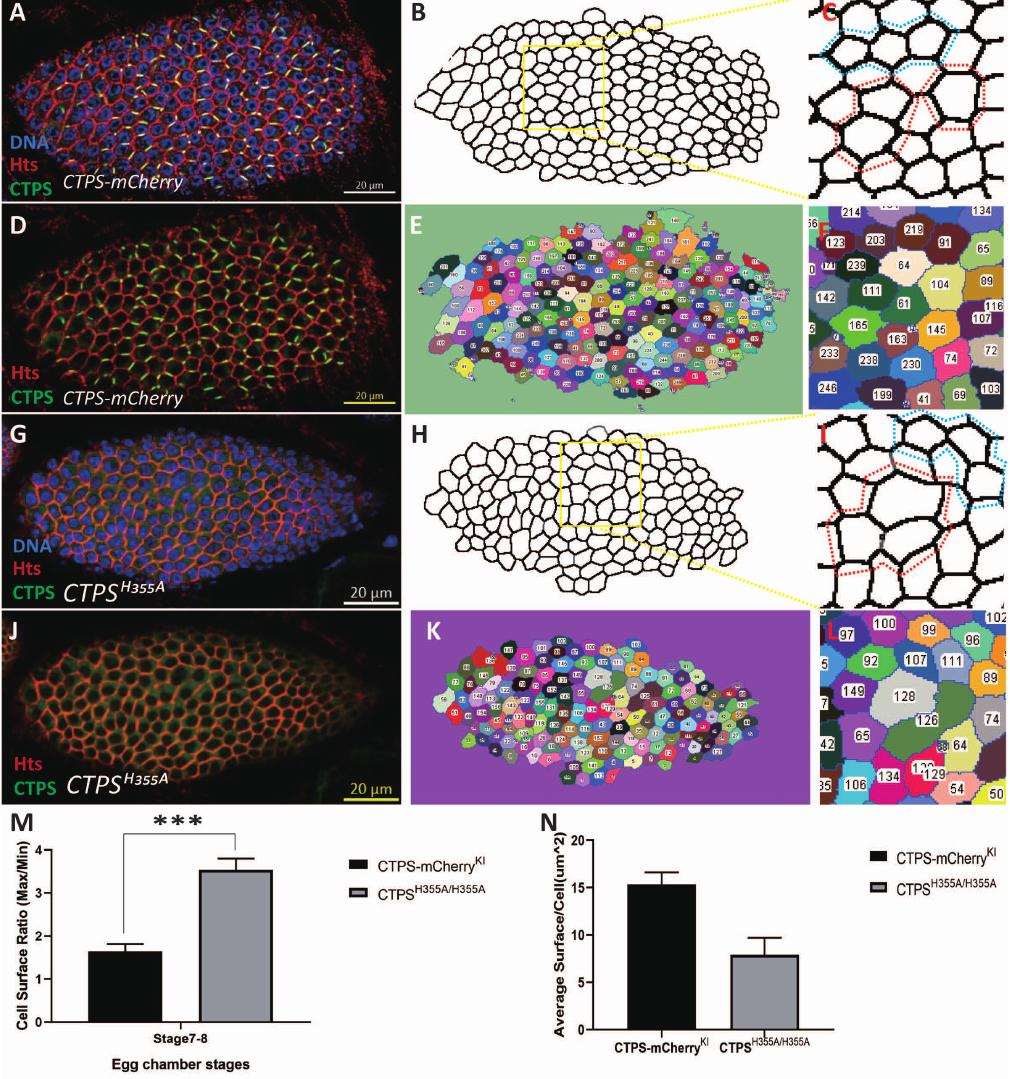
Figure 8. Quantitative morphological analysis of follicle cells. ( A ) Surface view of a stage 8 wild- type egg chamber. CTPS-mCherry (green), Hts (red) and DNA (blue, labeled with Hoechst